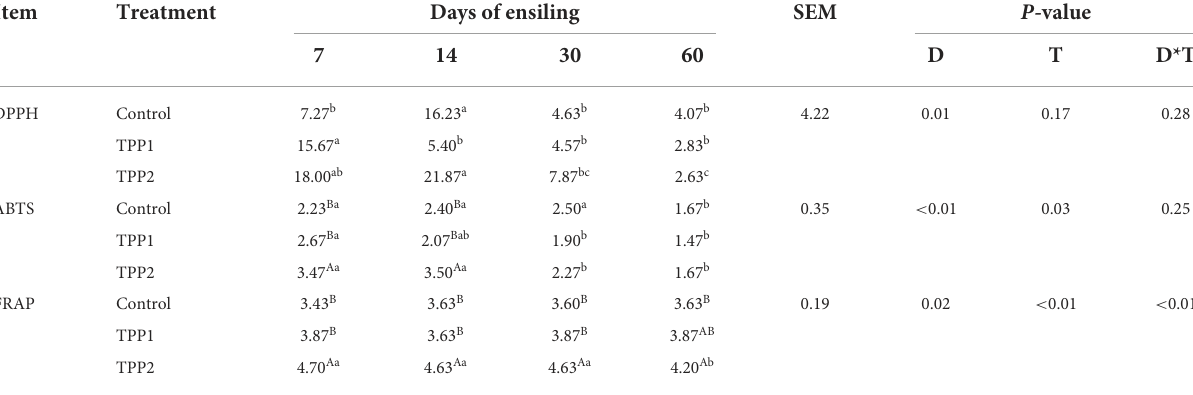
TABLE 4 Effect of tea polyphenols on the dynamic antioxidant capacity of stylo silage.